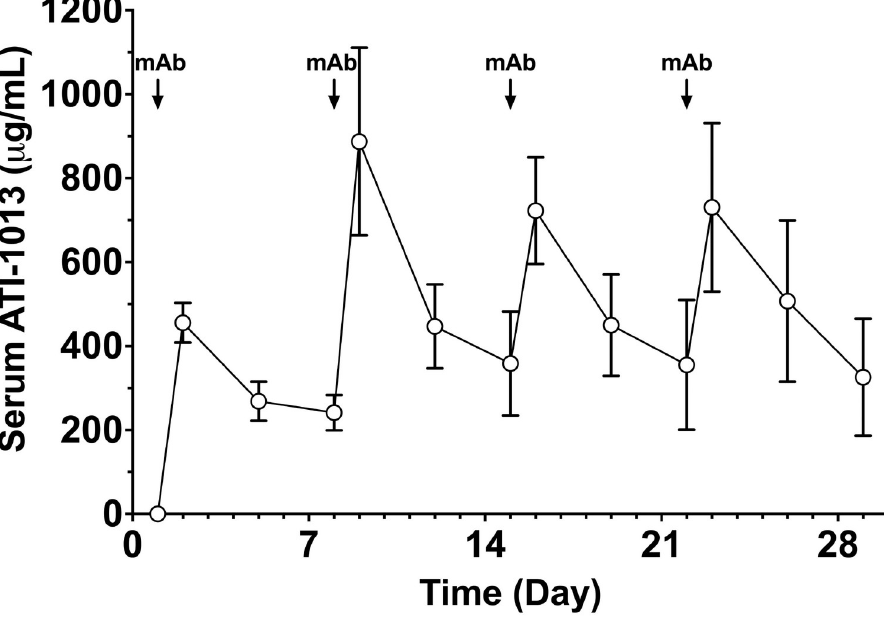
Fig 7. Distribution of ATI-1013 after weekly repeated dosing in rats. Age-matched SD rats (n = 6, 3M and 3F) received i.v. doses via FVC of 40 mg/kg ATI-1013 weekly for 4 weeks. Residual nic•mAb concentrations were measured at various time points after i.v. dosing. Arrows indicate times when ATI-1013 was administered. Data are expressed as mean ± SD.